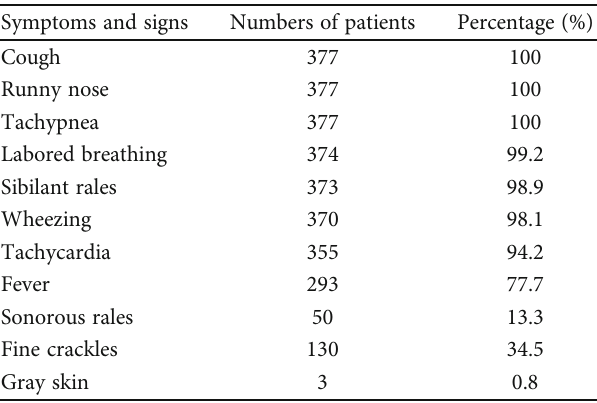
Table 5: The clinical characteristics of children with acute bronchiolitis caused by RSV ( N = 377 ).